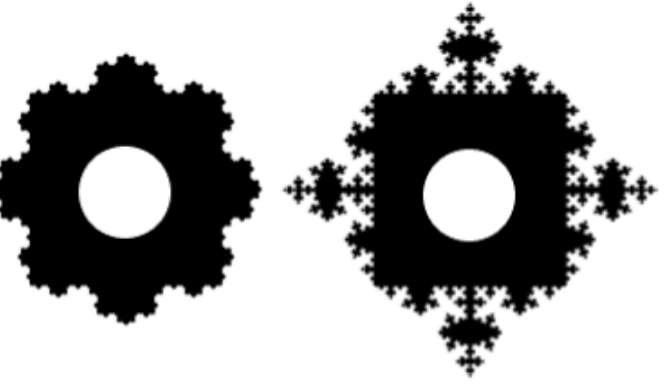
Figure 1. Koch curves outside the square. We have Neumann condition on ∂ E \ ∂ B and Dirichlet condition on ∂ B , where B is the Ball inside E . The domains are non-trap for the Brownian motion.